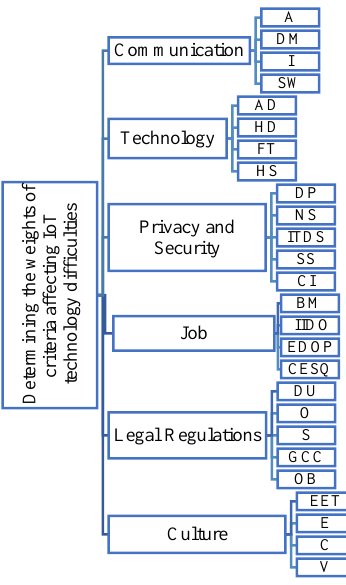
Figure 2. Hierarchical structure. Table 3. Binary comparison matrix for main criteria.